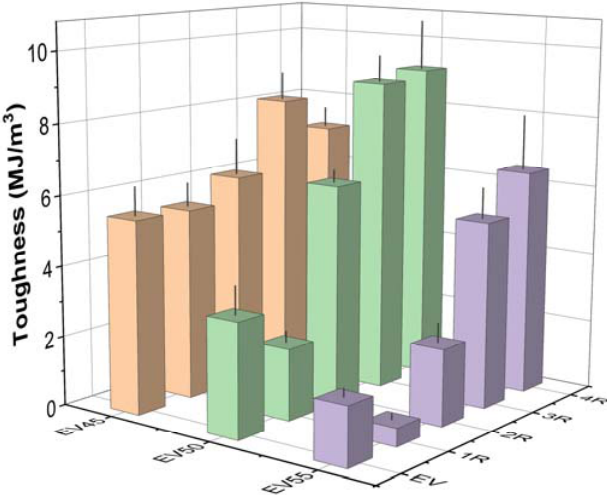
Figure 13. Elongation at break of the original and recycled epoxy vitrimers.